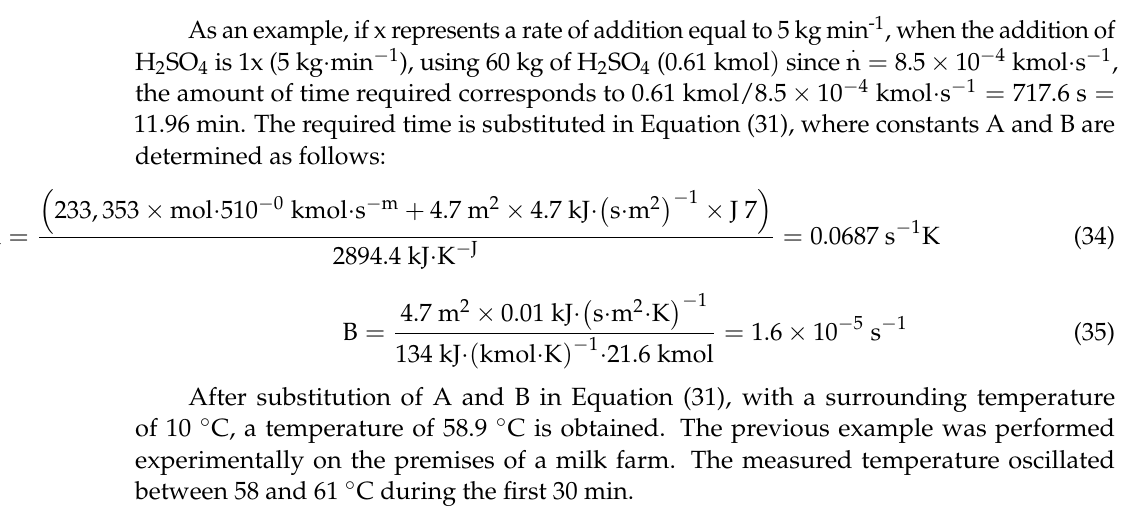
Figure 4. ( a ) Influence of rate of H 2 SO 4 addition on temperature and reaction time; ( b ) selected values of addition rate: ( □ ) rate: 5x (25 kg ∙ min − 1 ); ( Ο ) rate: 3x (15kg ∙ min − 1 ); (+) rate: 2x (10kg ∙ min − 1 ); ( ● ) rate: 1x (5kg ∙ min − 1 ). 0 (cid:3409) 𝜏 (cid:3409) 800 s